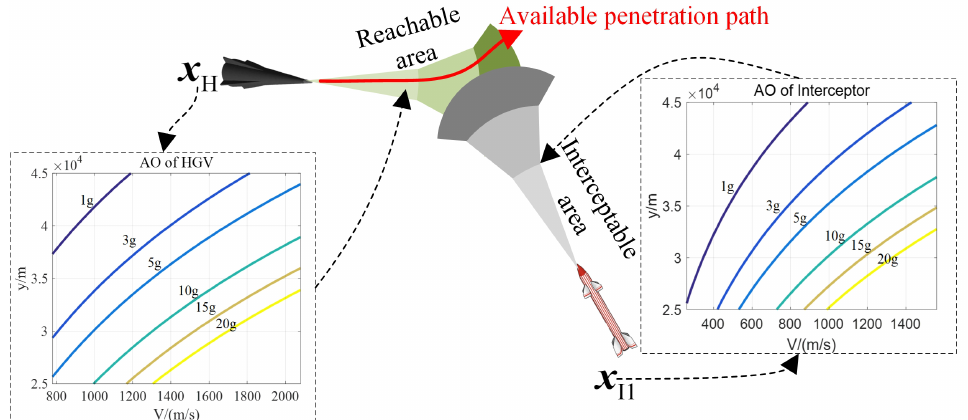
Figure 14. Illustration of the penetration strategy during the rendezvous phase learned by